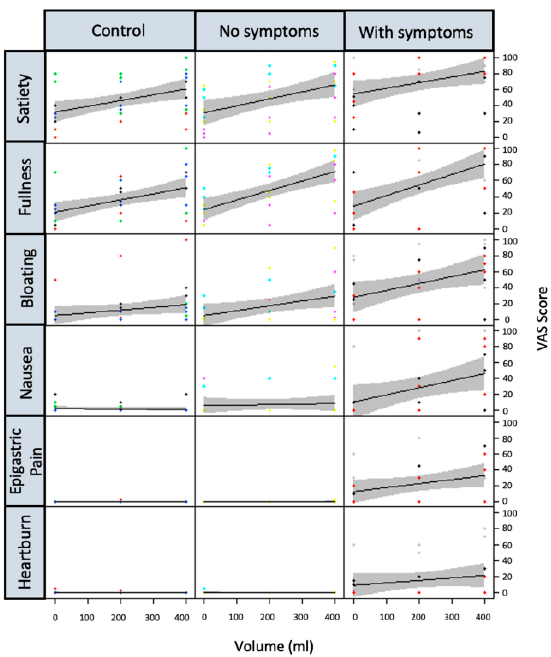
Figure 2. Postprandial symptoms recorded on visual analogue scale (100 mm VAS) during oral ingestion of the liquid Nottingham Test Meal (NTM) with 95% confidence bands at screening. Symptoms were recorded at baseline and after ingestion of 200 and 400 mL of the test meal. Satiety and fullness were similar in all three groups; however, dyspeptic symptoms were more marked in diabetic gastropathy (DG) patients. “Control”, healthy volunteers; “no symptoms”, diabetic controls without gastroparesis; “with symptoms”, patients with symptoms characteristic of diabetic gastroparesis.